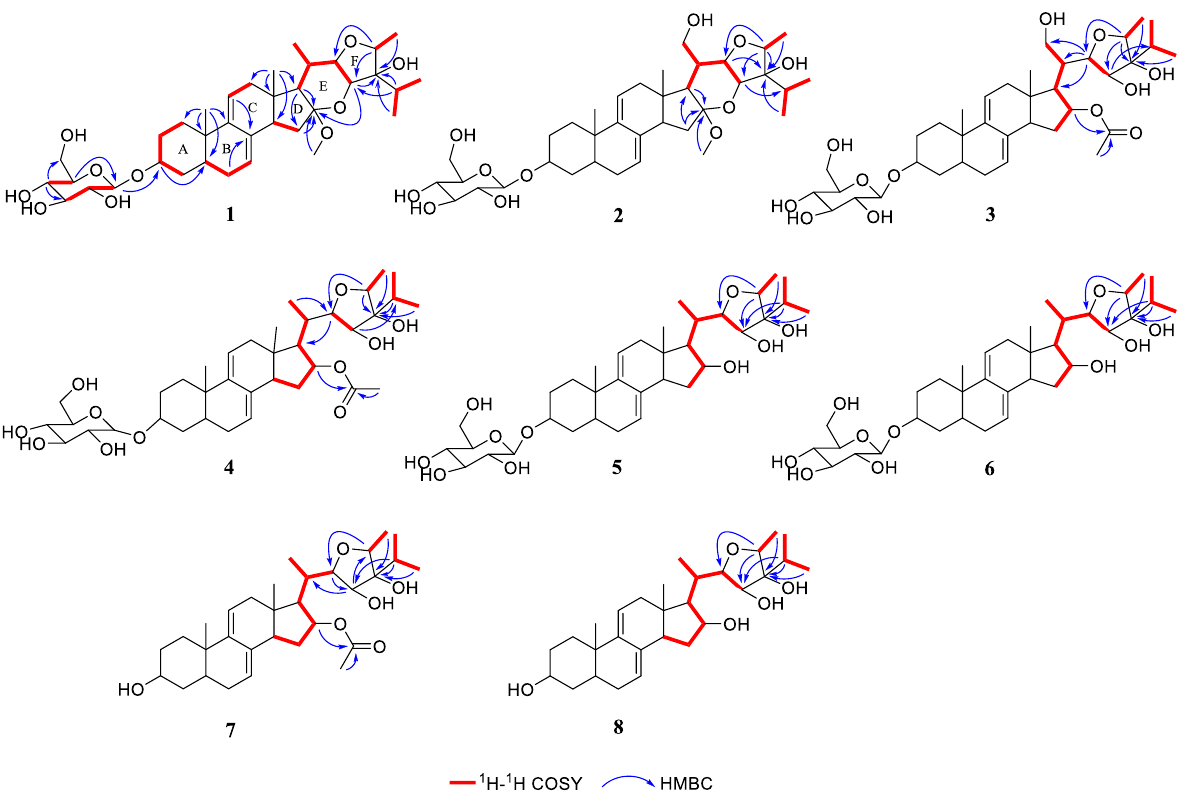
Figure 2. Key 1 H- 1 H COSY and HMBC correlations of compounds 1 – 8 .